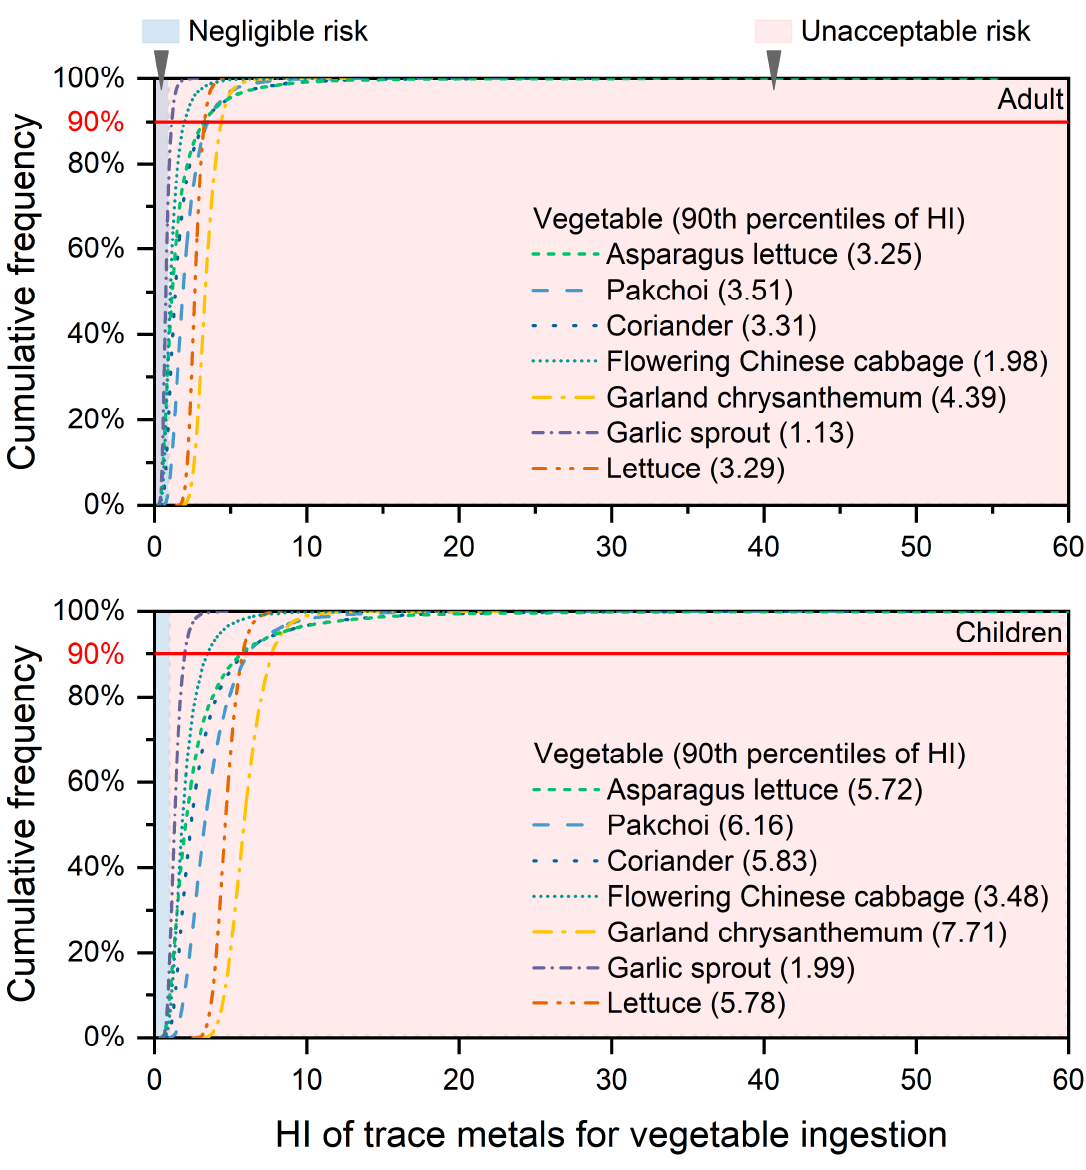
Figure 7. Probability distribution of hazard index (HI) caused by ingestion of vegetables grown in agricultural soils around the V-containing stone coal smelting site for adults and children.